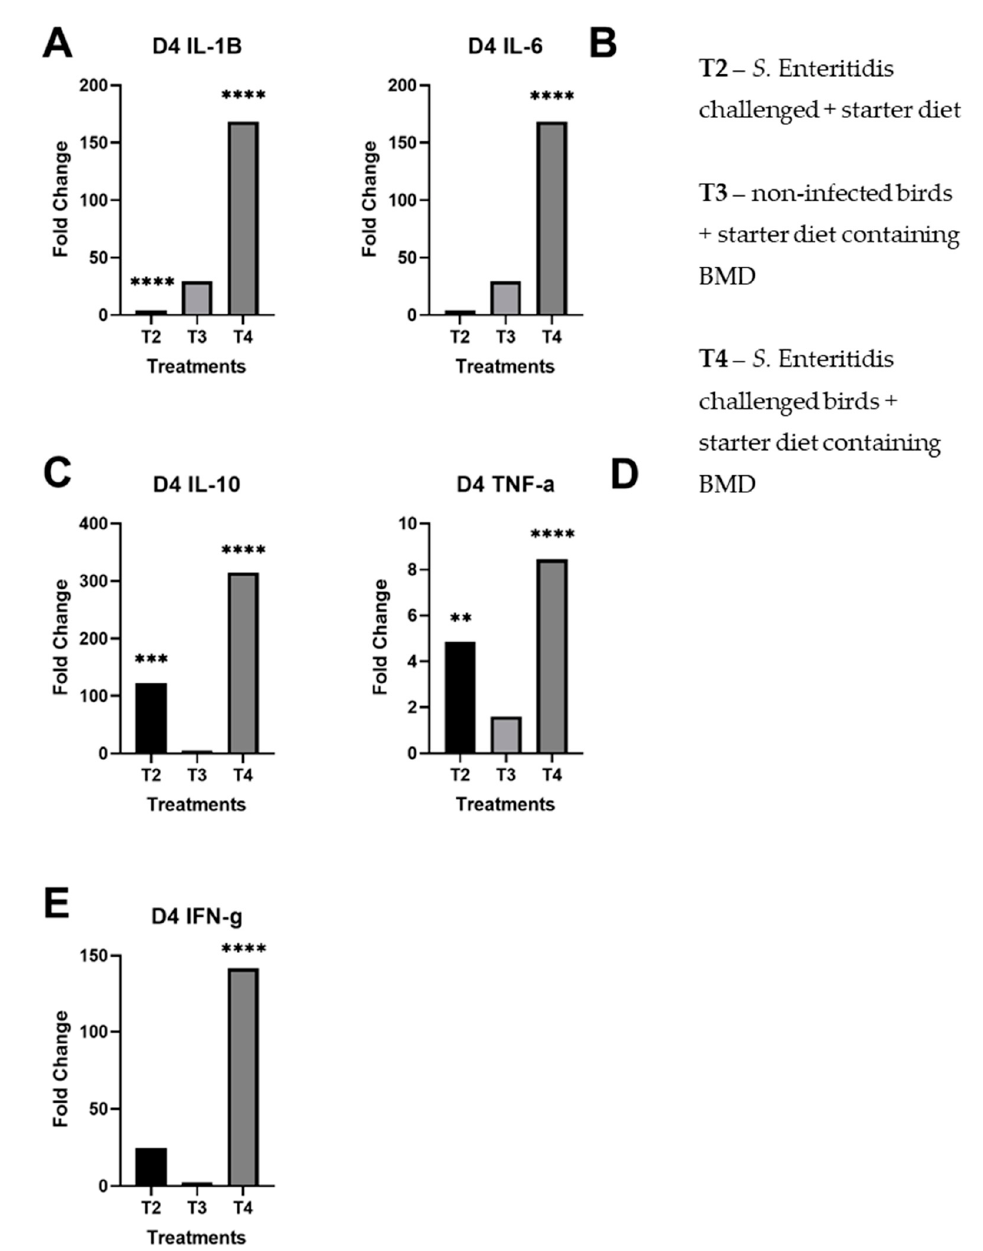
Figure 2. Fold changes of day 4 cecal samples by treatment per panel. These results for each treatment are compared against the control group (T1): ( A ) day 4 fold changes by treatment for IL-1 β ; ( B ) day 4 fold changes by treatment for IL-6; ( C ) day 4 fold changes by treatment for IL-10; ( D ) day 4 fold changes by treatment for TNF- α ; ( E ) day 4 fold changes by treatment for IFN- γ . The starred bars indicate di ff ering levels of significant p -values.